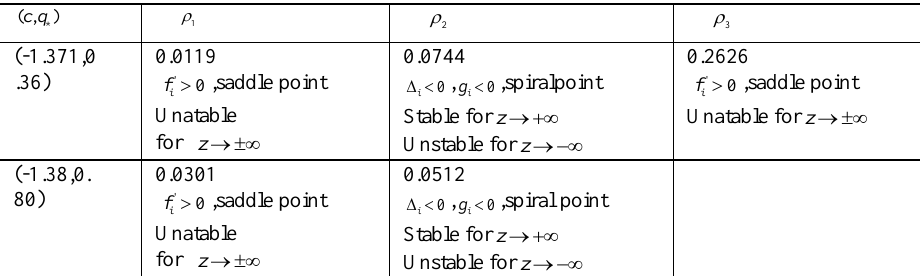
Table 2. Types and stabilities of some equilibrium points of linear system (11) with the given model parameters,